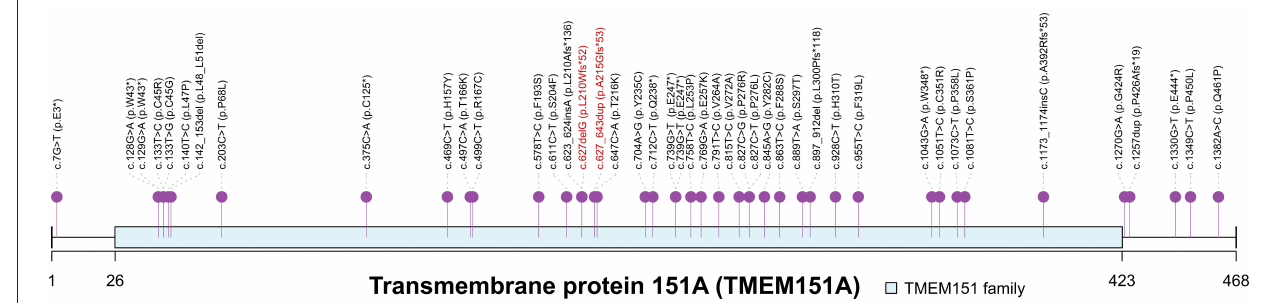
FIGURE 2 | Spectrum of TMEM151A mutations. PKD-associated mutations of TMEM151A gene were pinned. Two novel variants were labeled in red. The asterisk symbol indicates frameshift mutation.